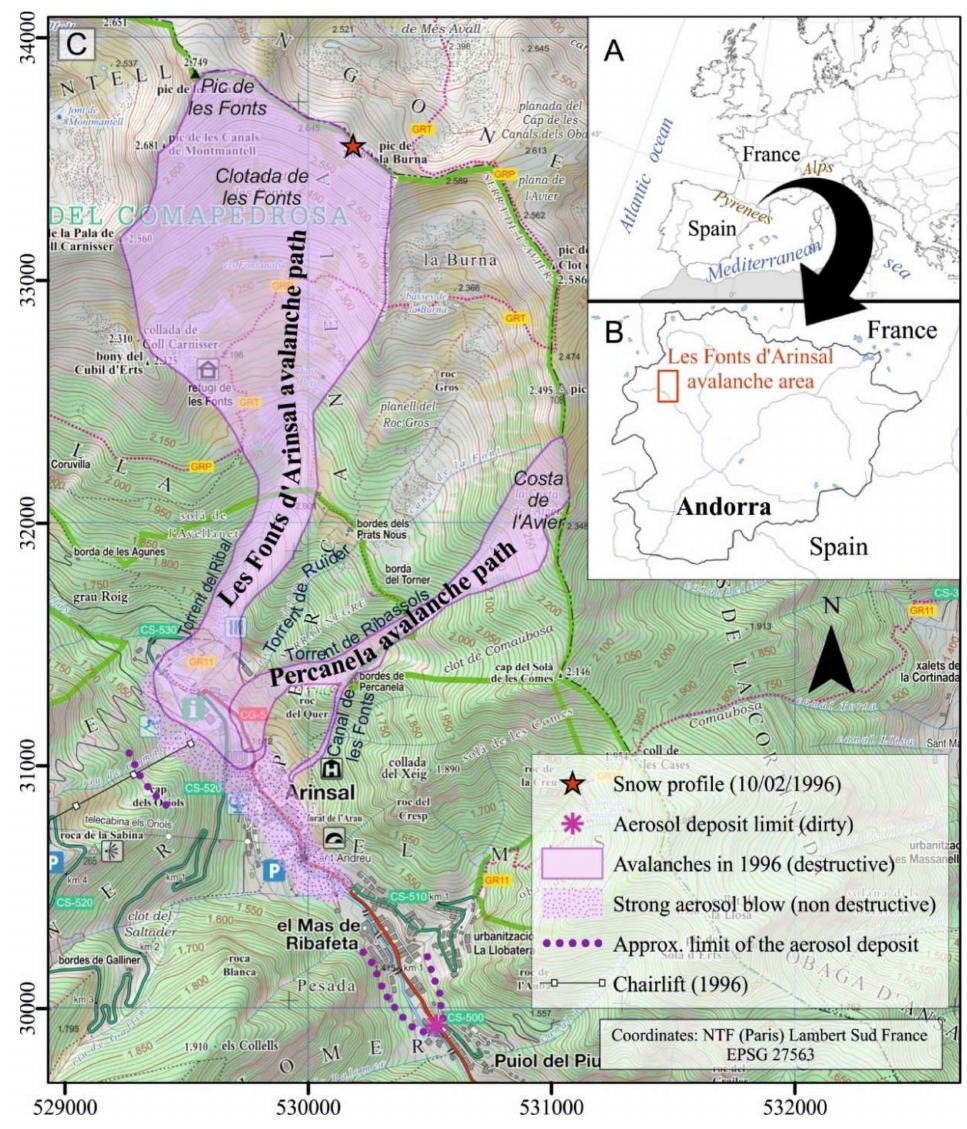
Figure 1. Geographical location of the study area: ( A ) location of the Pyrenees and Andorra in Europe; ( B ) location of the area of interest in Andorra; ( C ) locations of Les Fonts d’Arinsal-Torrent del Ribal (LFd’A) and Percanela-Costa de l’Avier avalanche paths, Arinsal village, the tourist complex and ski resort and the location of the snow profile on 10th February, 1996, marked with a red